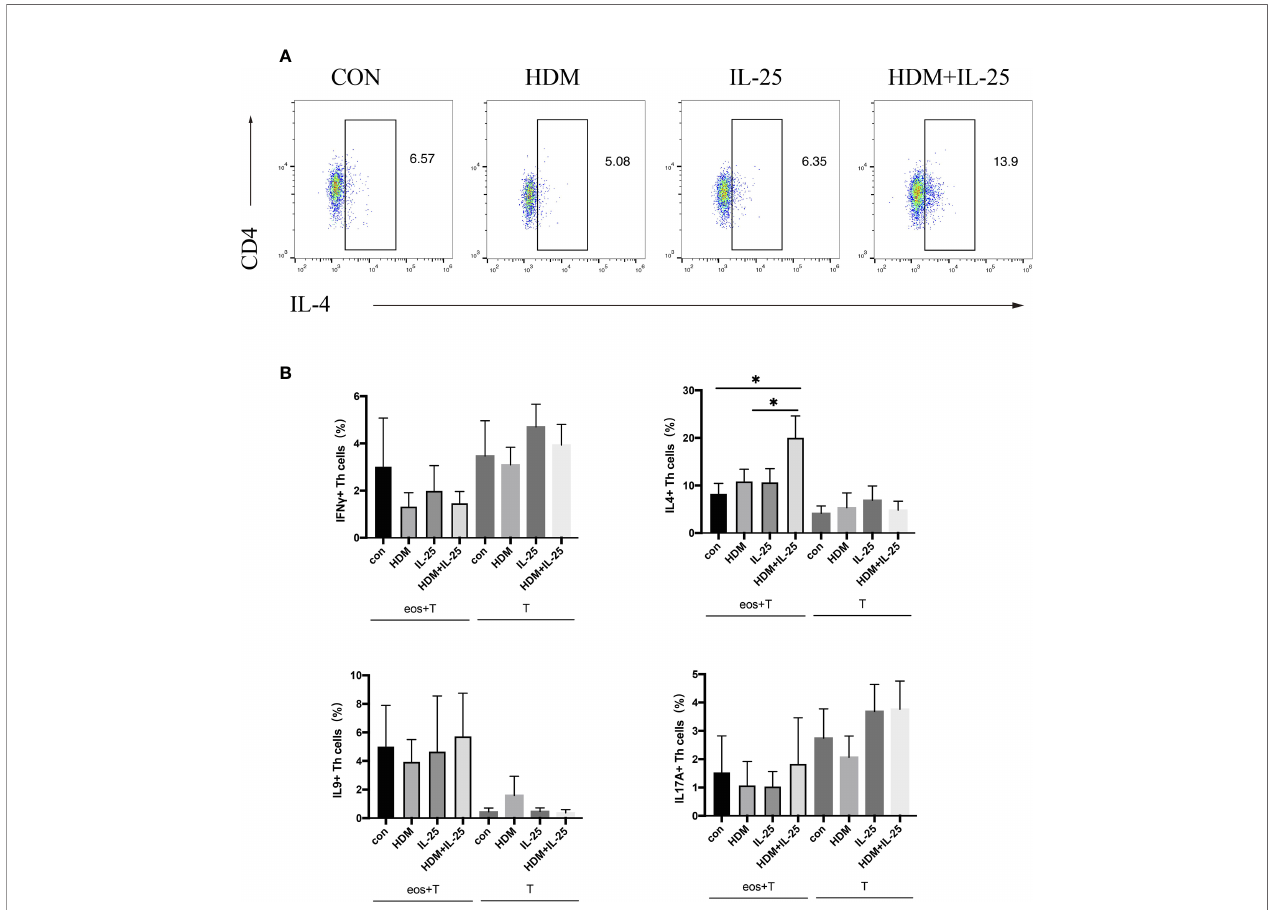
FIGURE 2 | IL-25 plus HDM-sensitized eosinophils promote Th2 differentiation of autologous naïve CD4 + T cells from allergic asthma patients. (A) Gated on viable CD4 + T cells (Zombie - CD3 + CD4 + cells), expression of intracellular IFN- g , IL-4, IL-9, and IL-17A were tested by fl ow cytometry. (B) Graphs show percentages of intracellular IFN- g , IL-4, IL-9, and IL-17A expression on CD4 + T cells in co-culture system or cultured alone. n = 5, *p <